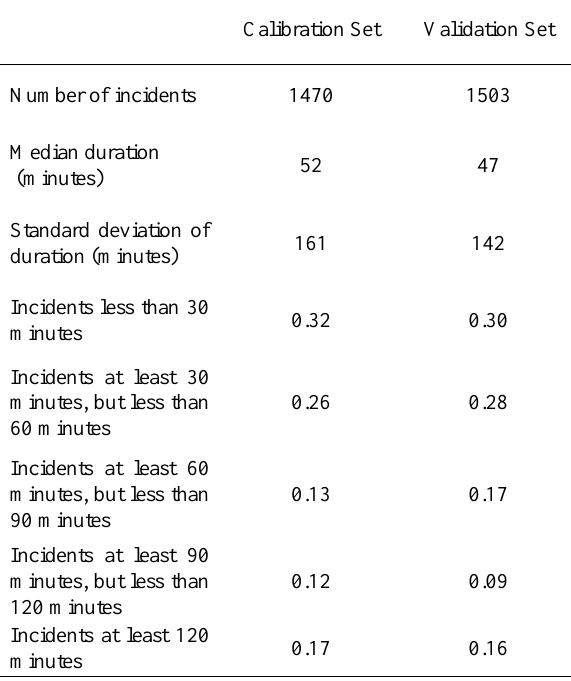
Table 1. Summary of incidents used to calibrate and validate models.